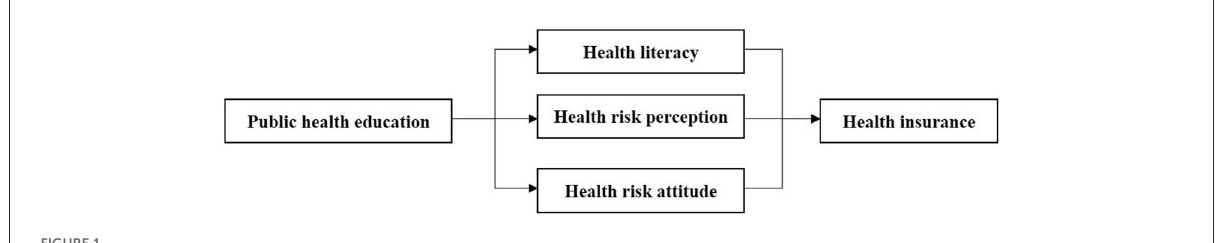
FIGURE1 Theoretical framework.